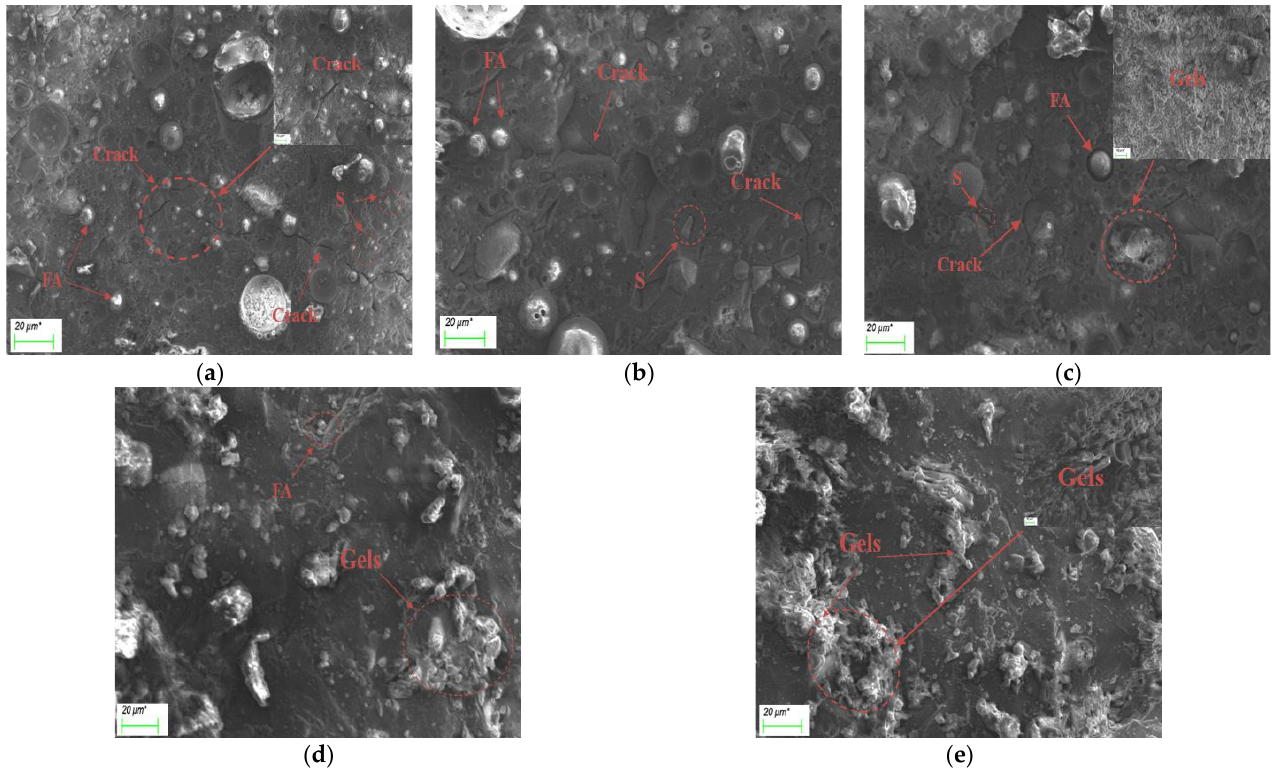
Figure 9. SEM images of alkali-activated composite cementitious materials under different slag con- tents: ( a ) S10C3; ( b ) S30C3; ( c ) S50C3; ( d ) S70C3; ( e ) S90C3. (μm* represents the unit μm) contents: ( a ) S10C3; ( b ) S30C3; ( c ) S50C3; ( d ) S70C3; ( e ) S90C3. ( µ m* represents the unit µ